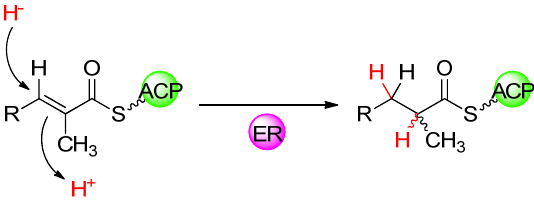
Figure 11. 1,4-Nucleophilic addition of hydride ion, delivered from NADPH, to the unsaturated thioester followed by stereospecific protonation, which establishes the configuration of the methyl